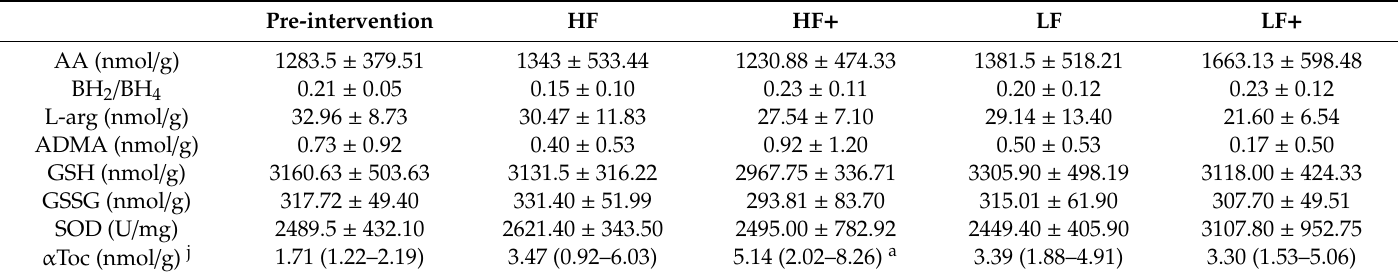
Table 4. Liver status, oxidative stress markers. Pre-intervention and Week